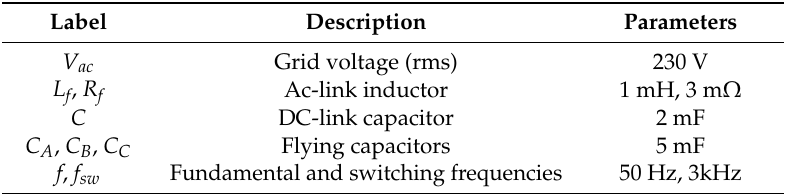
Table 1. Simulation circuit parameters.